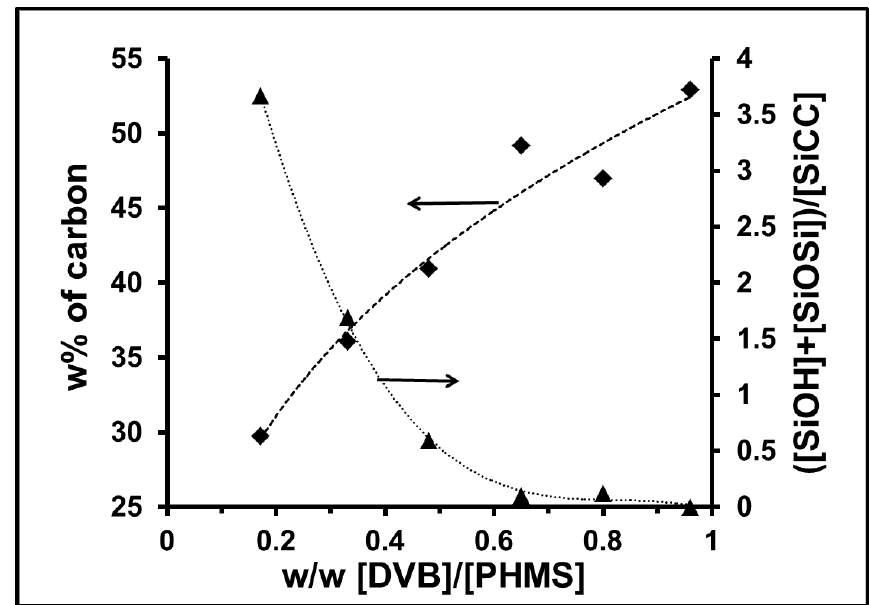
Figure 2. Effect of DVB proportion on the ratio of ([SiOH] + [SiOSi])/[SiCC] — ▲ and the carbon content in the precursor siloxane microspheres — .